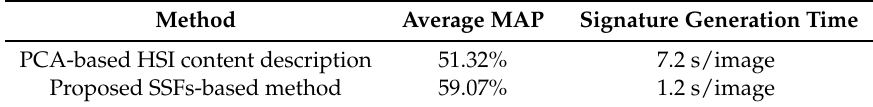
Table 5. Performance evaluation of our hyperspectral images content description approach with a method based on Principal Component Analysis (PCA) on the ICONES-HSI